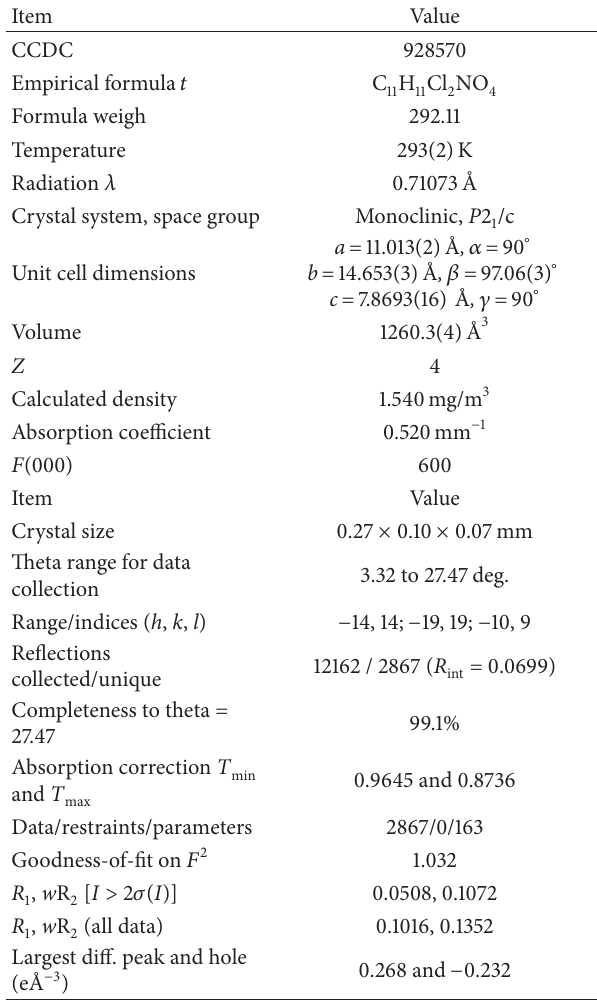
Table 1: Crystal and structure refinement for title